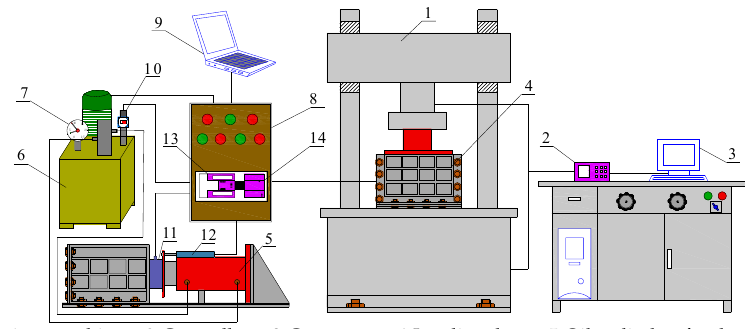
Figure 4. Schematic diagram of the bidirectional loading